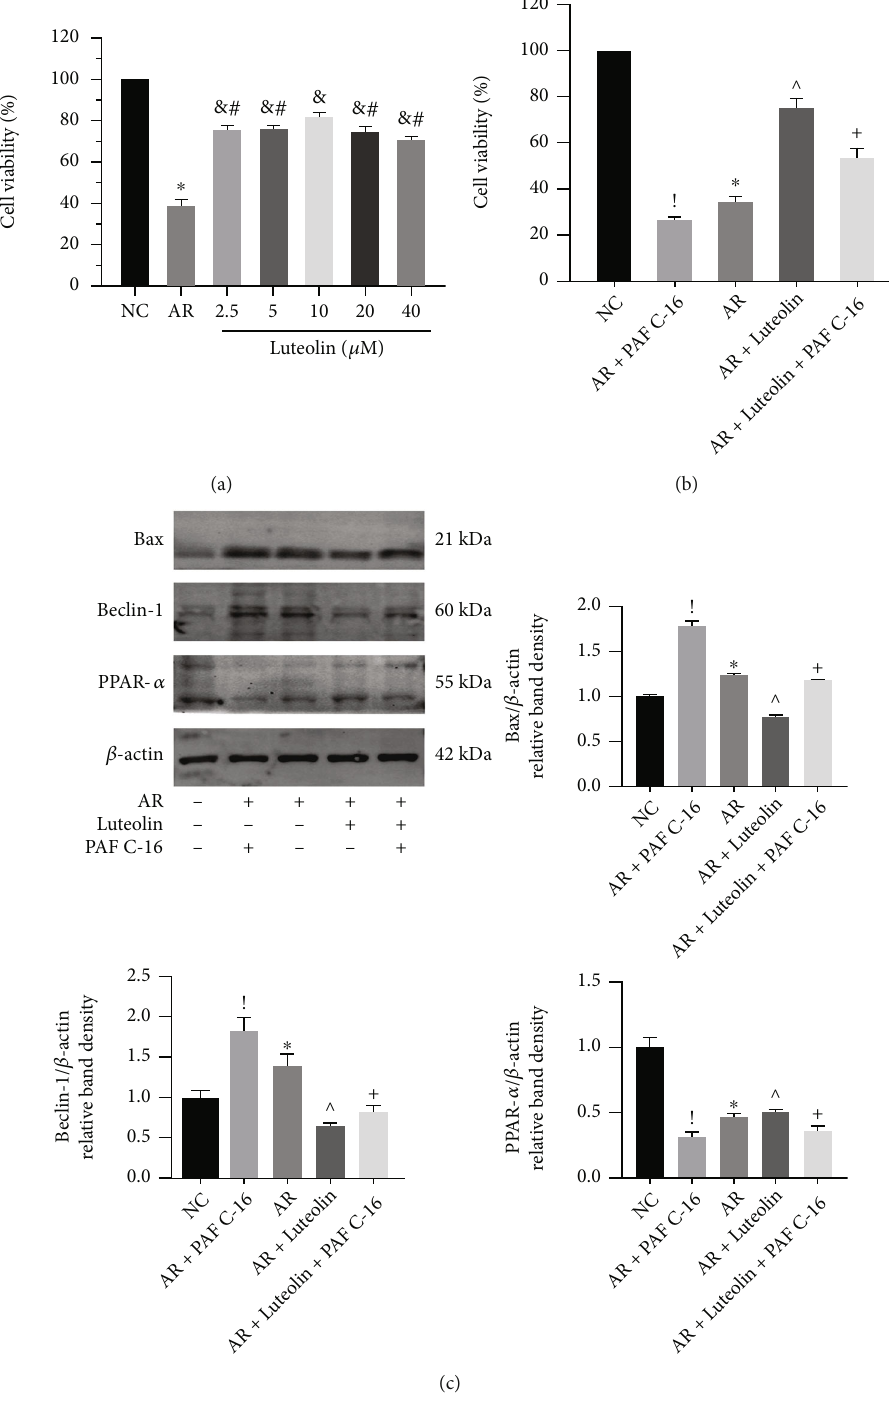
Figure 6: ERK/PPAR α pathway regulated hepatocellular apoptosis and autophagy. (a) Cell viability was measured by CCK-8 assay under di ff erent doses of luteolin ( n = 3 ; ∗ p < 0 : 05 vs. NC group; & p < 0 : 05 vs. AR group; # p < 0 : 05 vs. 10 μ M luteolin group). (b) Cell viability under di ff erent treatments was measured by CCK-8 assay. (c) Western blotting analysis of Bax, Beclin-1, and PPAR α . The western blot results were quanti fi ed with ImageJ 8.0 software ( n = 3 ; ! p < 0 : 05 for AR+PAF C-16 vs. AR; ∗ p < 0 : 05 for AR vs. NC; ^ p < 0 : 05 for AR +luteolin vs. AR; + p < 0 : 05 for AR+luteolin+PAF C-16 vs. AR+PAF